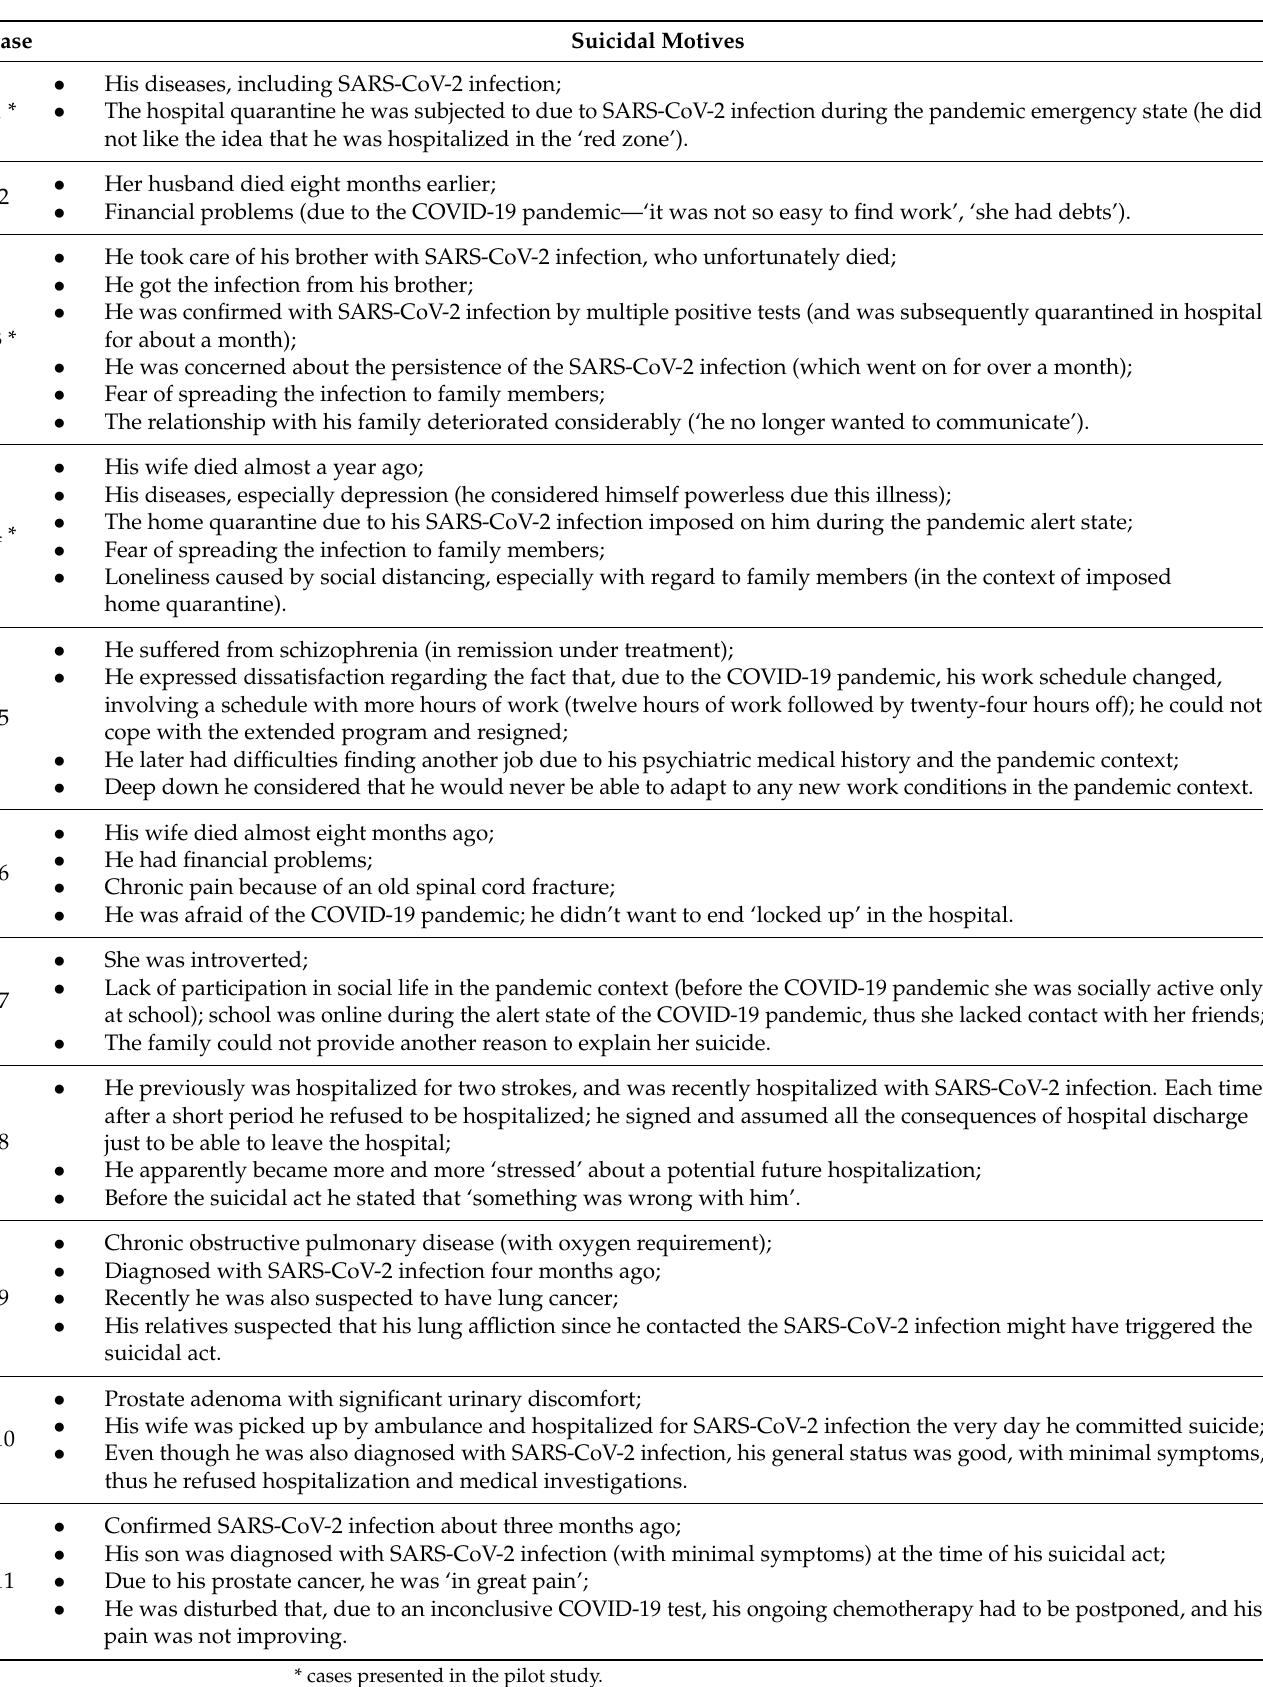
Table 3. Suicidal